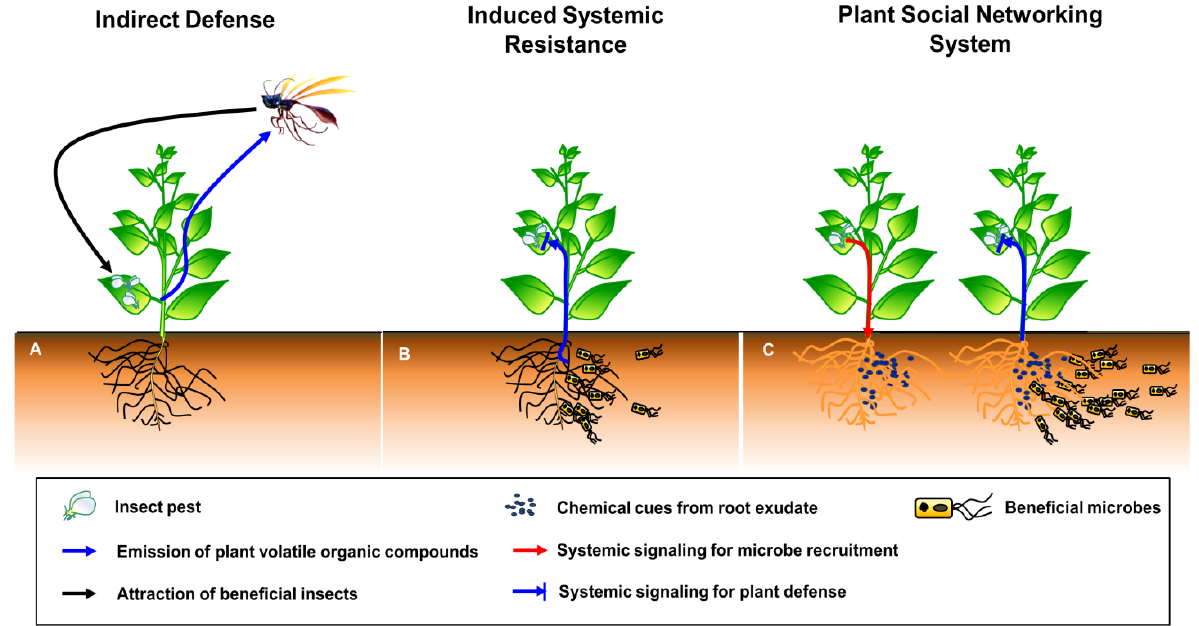
Figure 1. Schematic representation of the plant defense response. ( A ) Indirect defense. Whitefly infestation elicits the plant defense response, which indirectly suppresses the performance of insects attracted by natural volatiles. ( B ) Induced systemic resistance (ISR). Beneficial microbes in the rhizosphere induce systemic signals and systemic-acquired resistance against pathogens and insects. ( C ) Plant social networking system (pSNS). Insect infestation and pathogen infection of aboveground tissues induces the secretion of root exudates into the rhizosphere, which leads to the recruitment of beneficial microbes, thus activating systemic resistance against pathogens and insects.